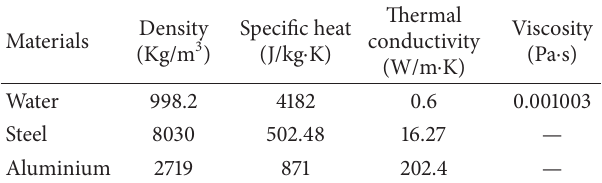
Table 1: Thermo-physical properties of materials.